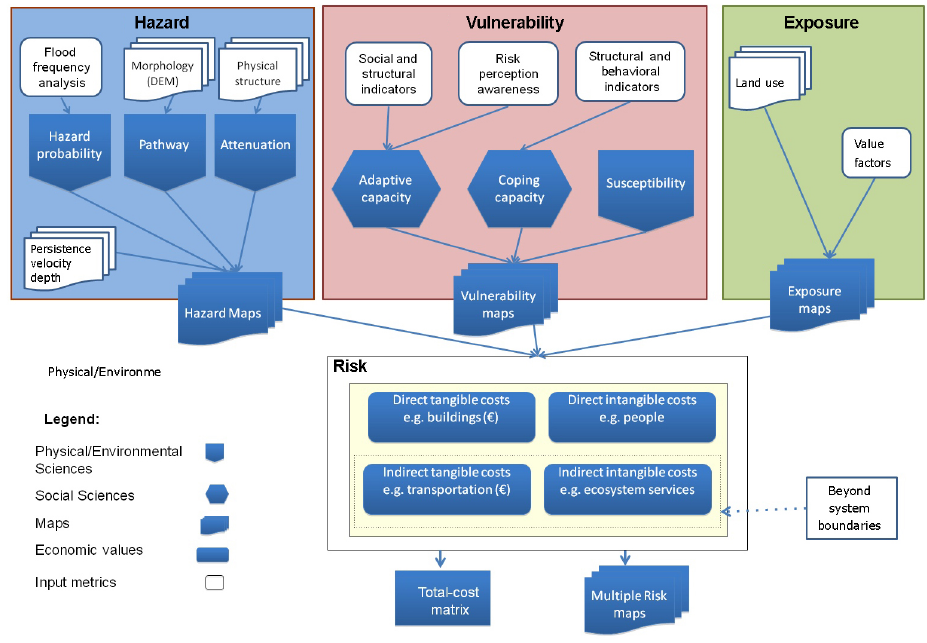
Figure 1. The KULTURisk framework with the identification of the main sources of data . Note: concept definitions are available in Giupponi et al.